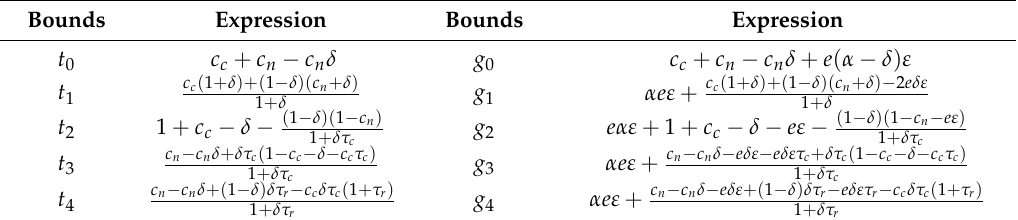
Table 3. Bounds of u describing the characteristics of the optimal